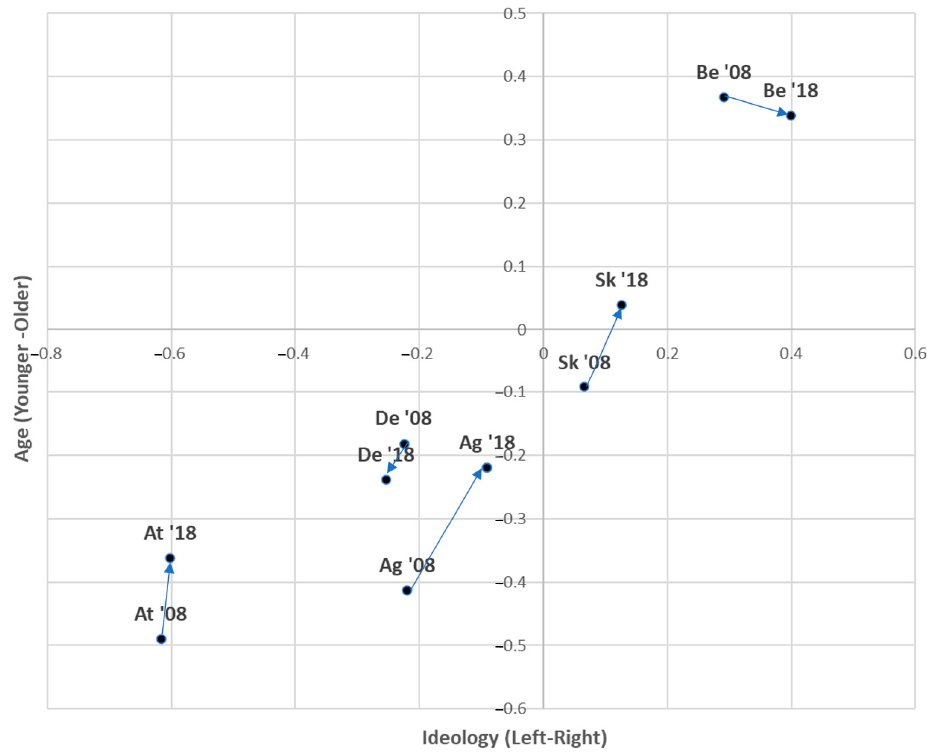
Figure 1. Religious options according to ideology and age. (At = Atheist; Ag = Agnostic; De = Deist; Sk = Skeptic believer; Be = Believer).